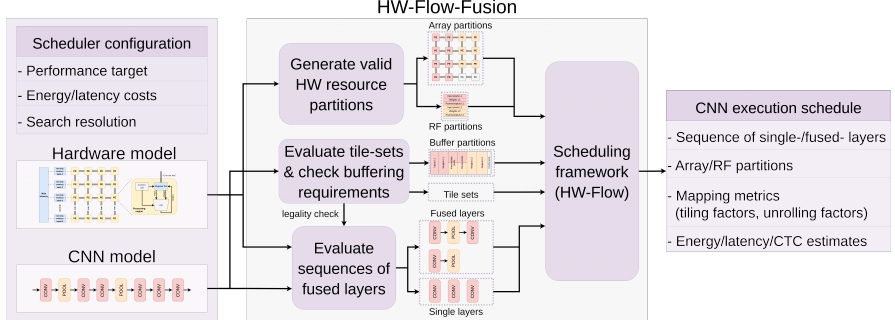
Figure 11. Overview of the inter-layer scheduling framework. The framework takes as input a CNN model with layer types and dimensions, an abstract hardware model with memory and PE array specifications, and scheduler settings such as the energy/delay model and search resolution. Valid partitions, tile sets, and sequences of layers are evaluated and marked for single- or inter-layer scheduling. The output schedule is composed by the mapping parameters and performance